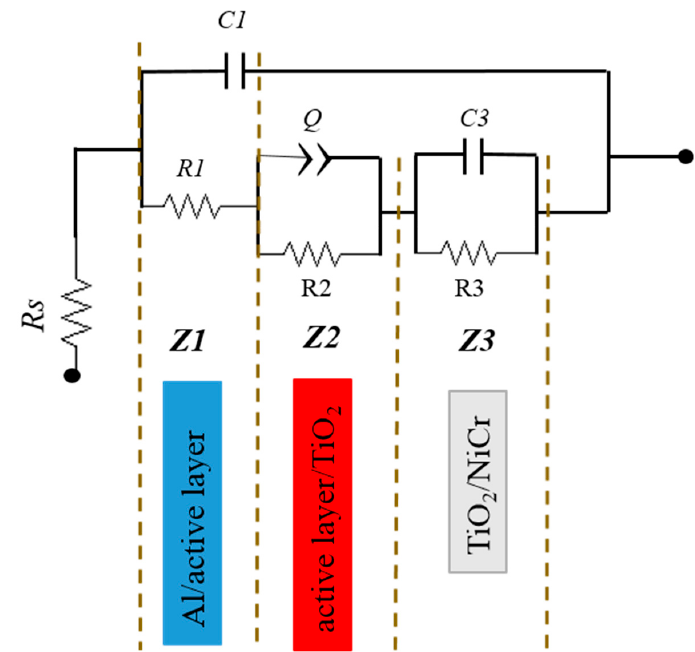
Figure 4. AC equivalent circuit model proposed to study the electrical behavior of the three Si-based MIS Schottky barrier diodes analyzed in this work. Depending on the particular diode, the active layer will be Si, Si+nanoPS, or Si+nanoPS+AgNPs.